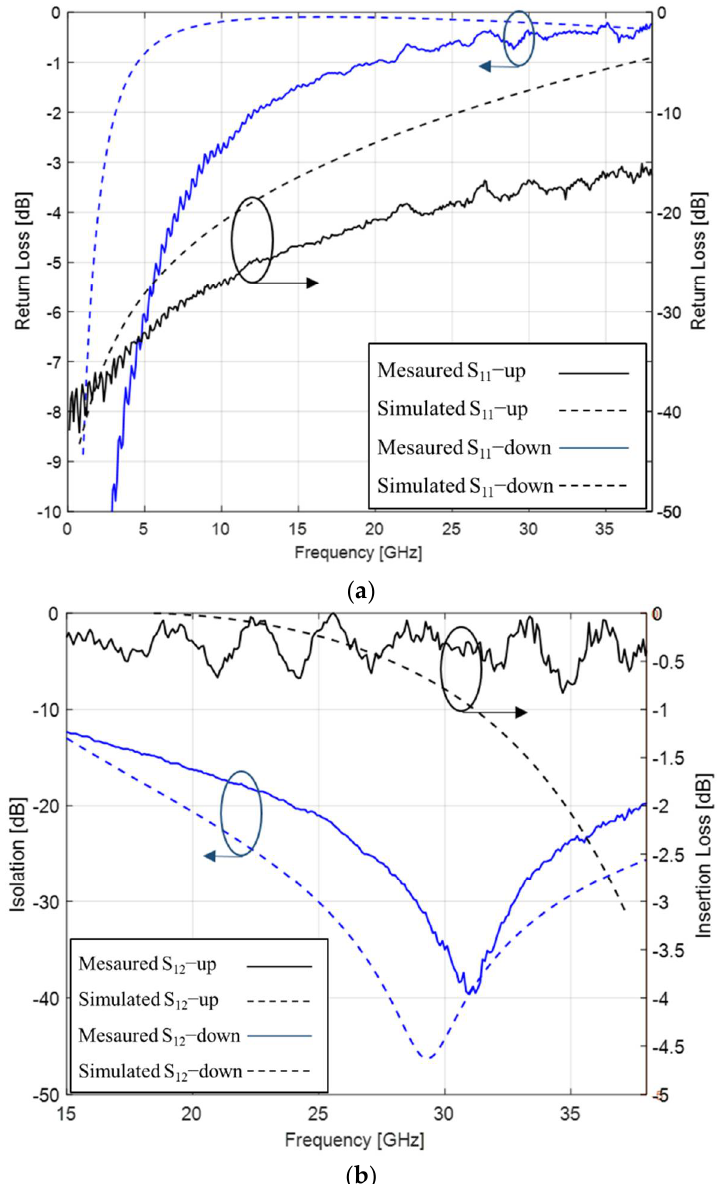
Figure 10. S−parameters of the MEMS switch: ( a ) S11 of the measured and simulated results; ( b ) S12 of the measured and simulated results.